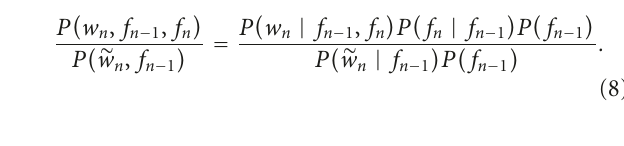
Table 4: Additional primitives for completion of boundary cliques. Additional primitives Type of primitive Boundary States Left Observations Right States